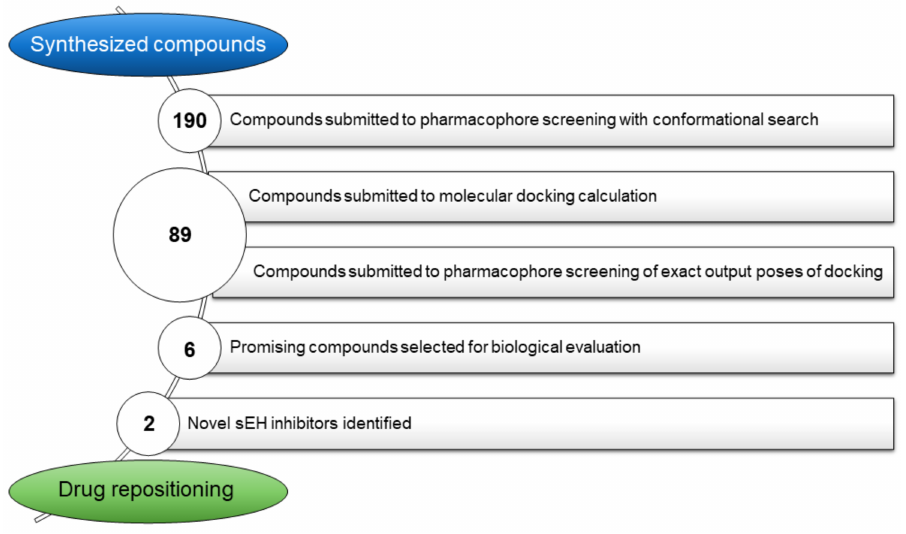
Figure 7. Detailed workflow for repositioning of compounds 3 – 8